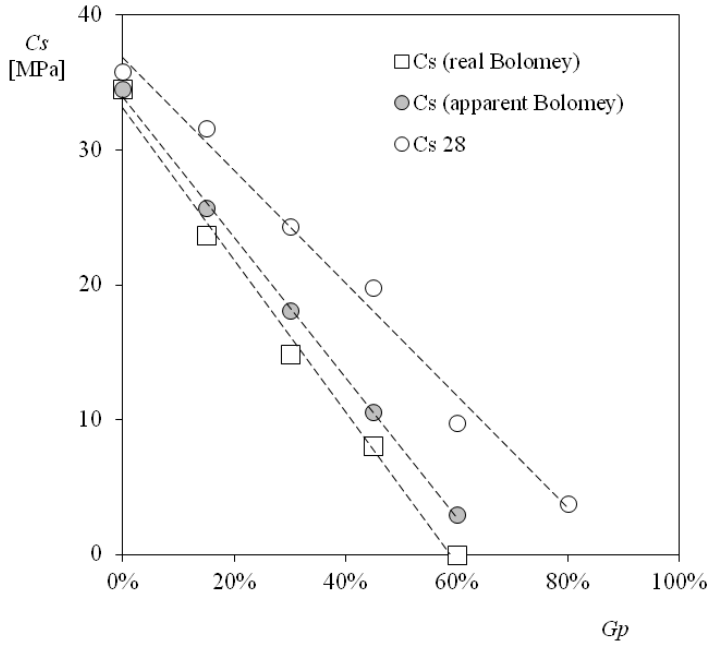
0.999 ( C S apparent Bolomey); R 2 = 0.993 ( C S real Bolomey). Figure 7. Compressive strength, Cs , 28 days after setting, with regard to the amount of glass powder